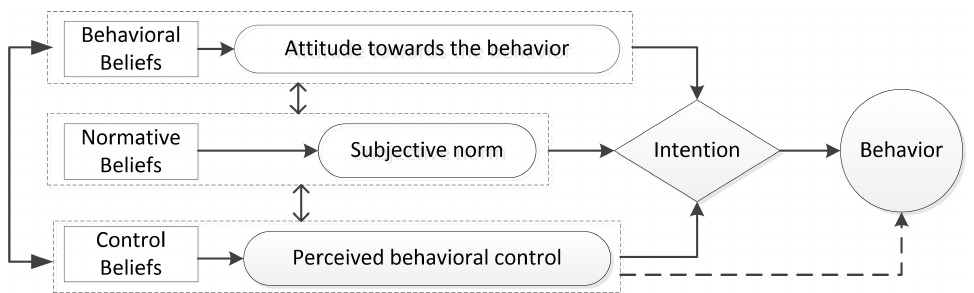
Figure 7. Theory of planned behavior.